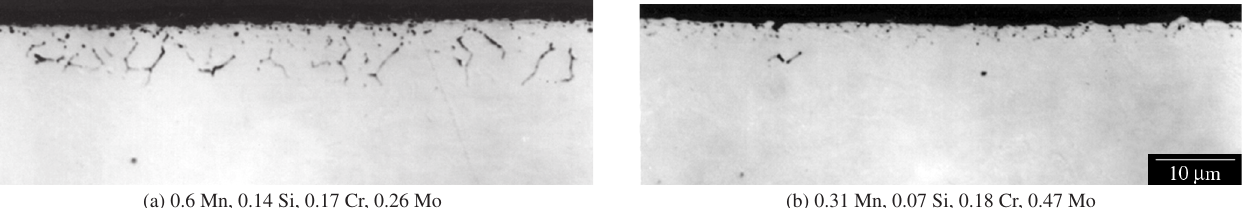
.(a) 0.6 Mn, 0.14 Si, 0.17 Cr, 0.26 Mo Figure 2. Light optical micrographs (unetched) showing surface oxidation in gas carburized samples of modified 4320 steels (compositions, wt. (%)): a) high Mn, high Si, endurance limit 1075 MPa; and b) low Mn, low Si, endurance limit 1350 MPa 13